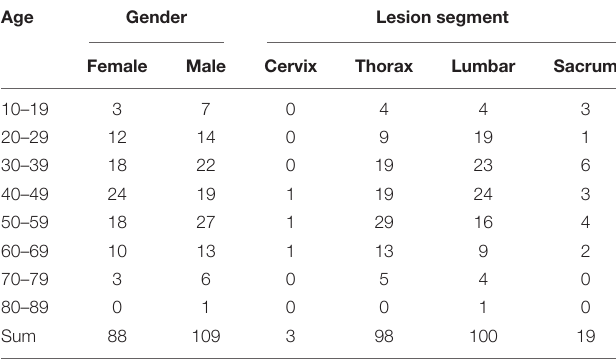
TABLE 1 | Information of patient with spinal